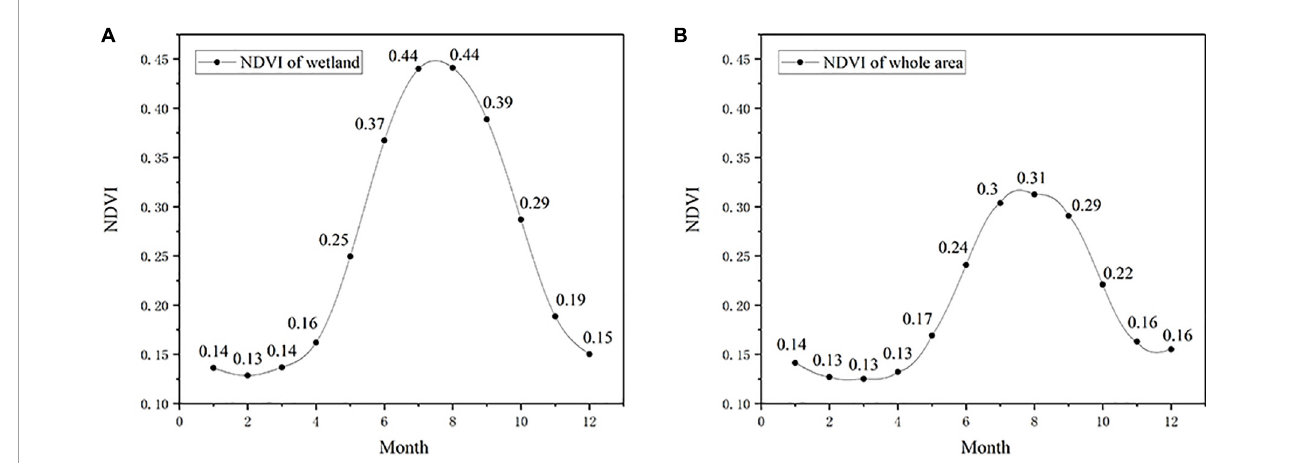
FIGURE2 The multi-yearly seasonal variation for (A) averaged normalized difference vegetation index (NDVI) of wetland and (B) averaged NDVI in the TP.